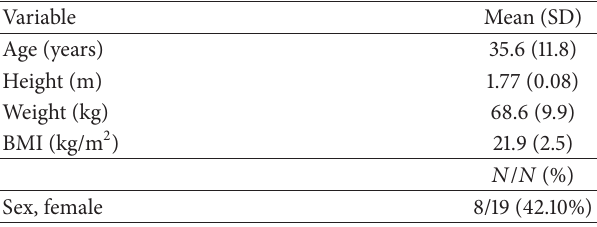
Table 1: Characteristics of participants.